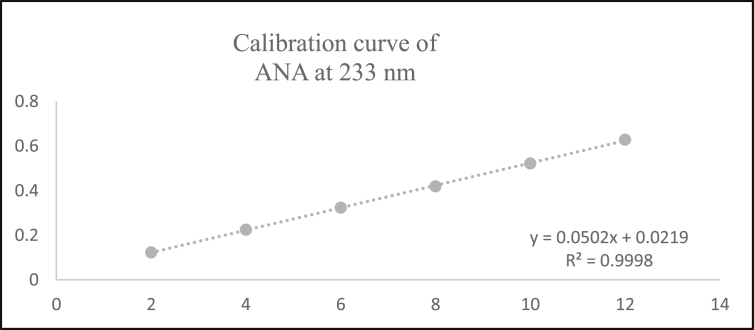
Calibration curve of ANA at λ2 = 233 nm.